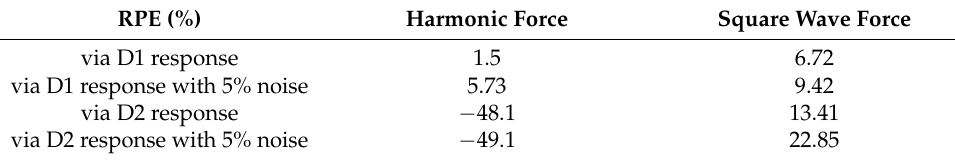
Table 1. RPE of fixed periodic load